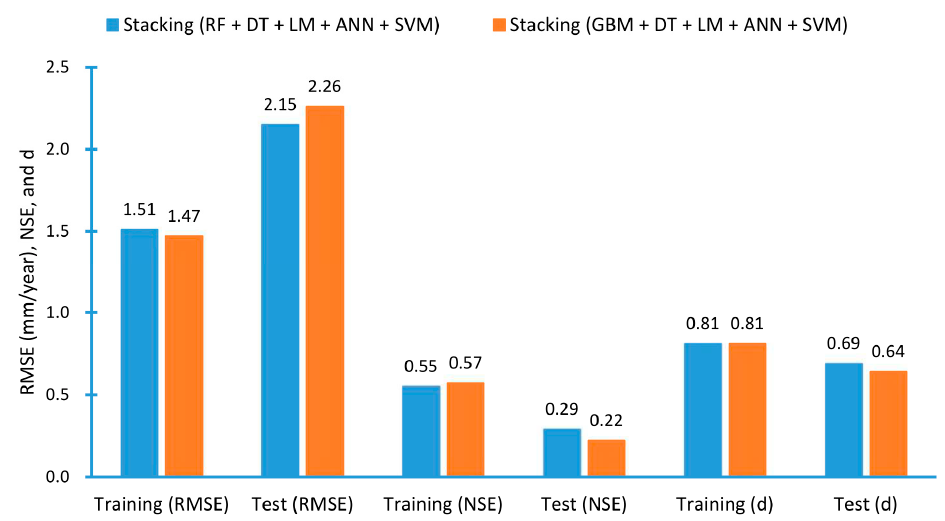
Figure 6. The comparison of RMSE (mm/year), NSE, and d between RF-stacking and GBM-stacking.